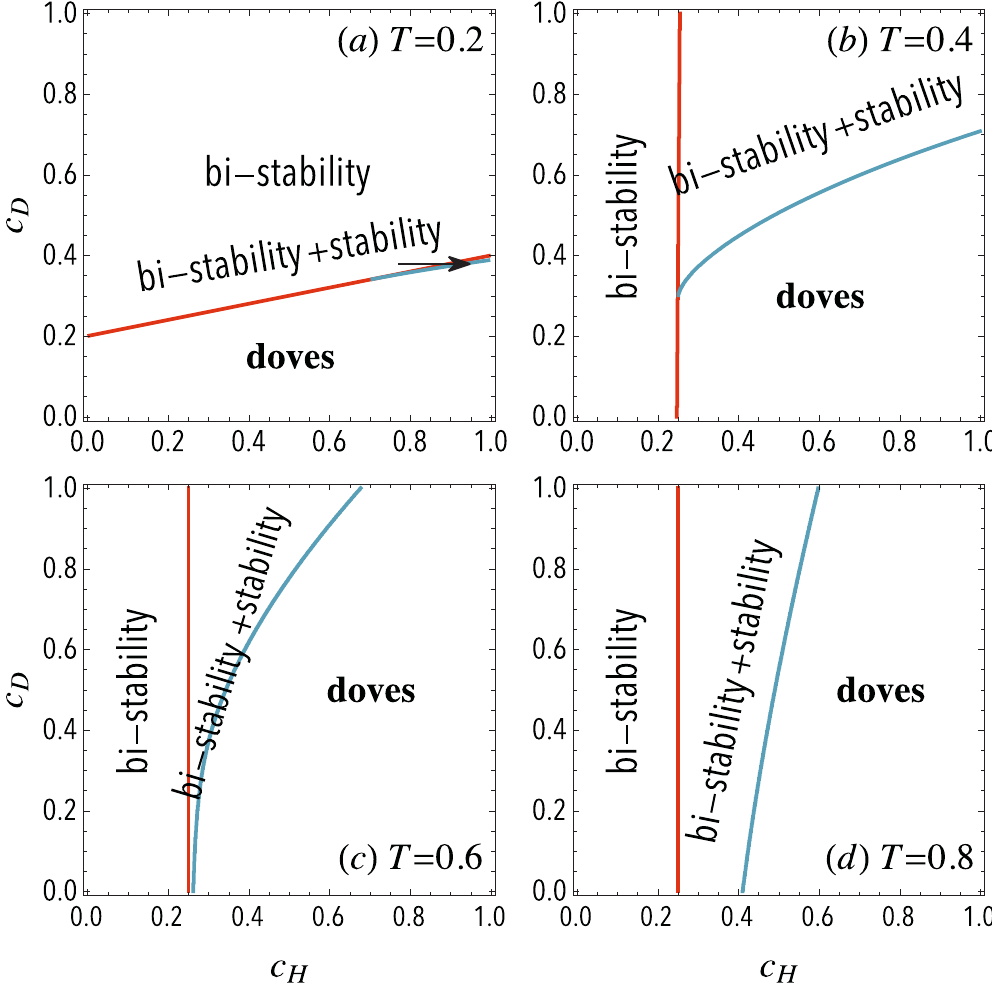
Figure 4. Phase diagrams for the N-person Hawk-Dove Game with threshold. Diagrams show the different regimes in the N-person HDG-T for a sample size of N = 5 and an infinite population. Different panels correspond to different thresholds T = 0.2, 0.4, 0.6, 0.8 respectively. Within the bi-stability regime both full-dove state and full-hawk state can be reached from different initial conditions, while the bi - stability + stability regime corresponds to coexistence state together with full-dove state. In the doves regime the dynamics always leads to a full-dove state. The resource is taken R =